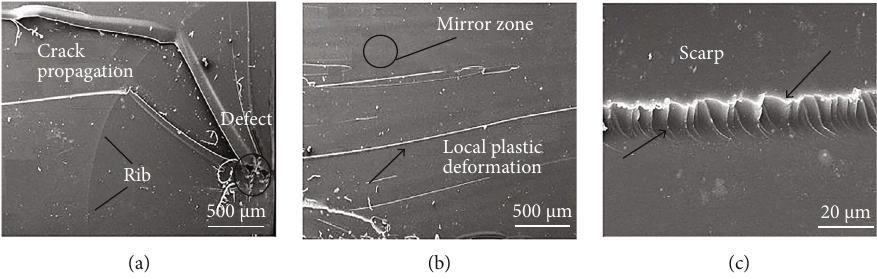
Figure 8: Micrograph image of epoxy sample fractured at 50 ° C creep test.